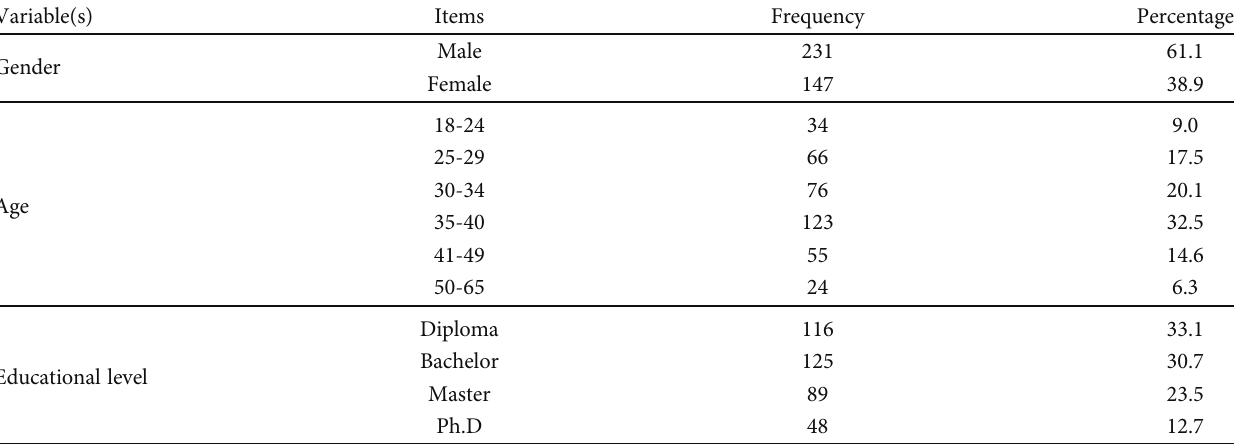
Table 2: Demographic pro fi le of respondents ( n = 378 ).